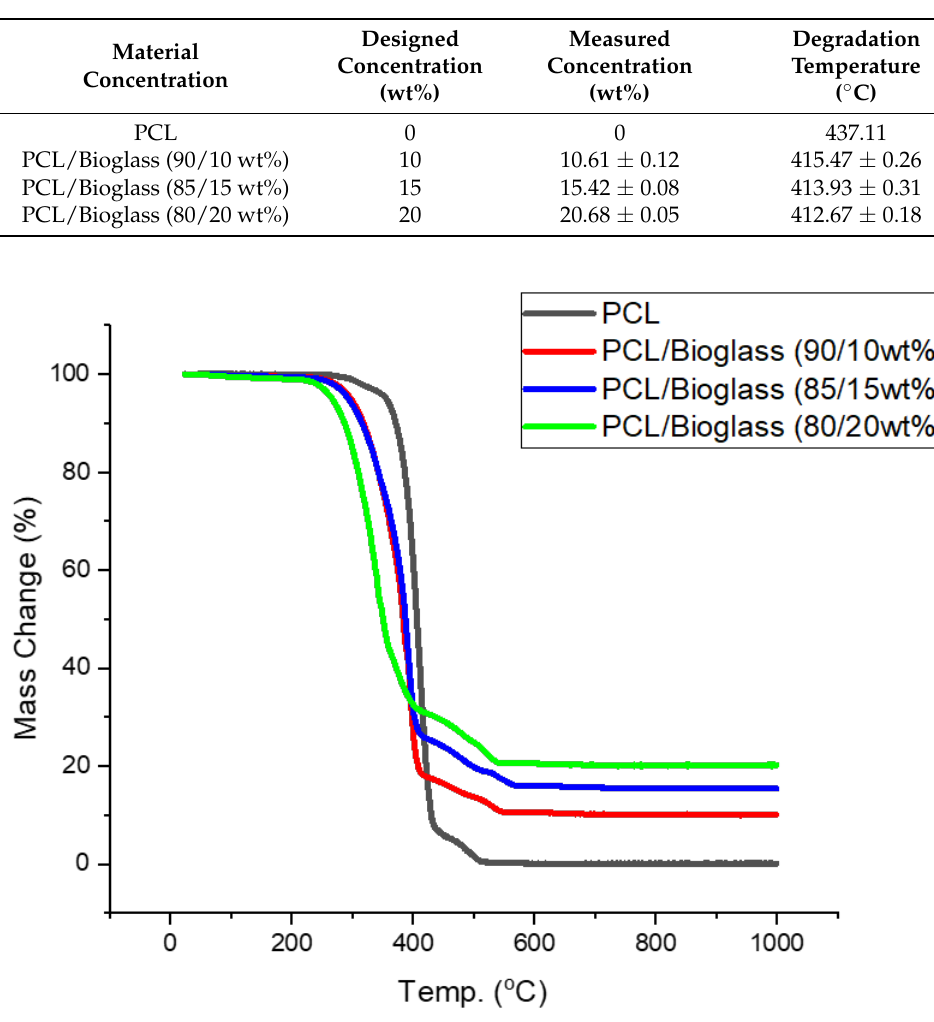
Table 3. The designed and manufactured concentrations of the bioglass bone bricks.